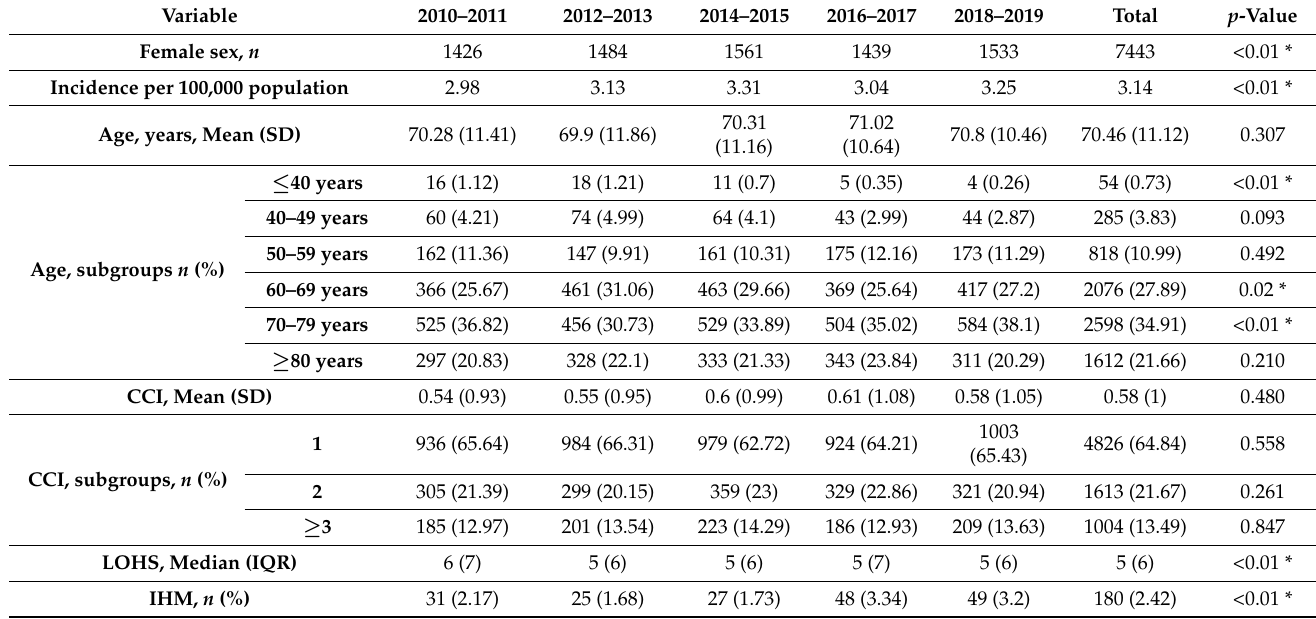
Table 3. Characteristics of Hospital Admissions of Female Patients with Parkinson’s Disease as a Primary Diagnosis in Spain